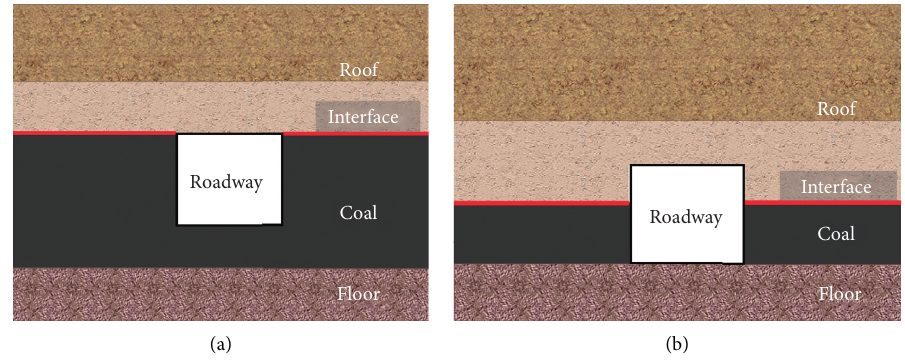
Figure 1: Two types of roadways. (a) Roadway driving along the roof. (b) Semicoal-rock